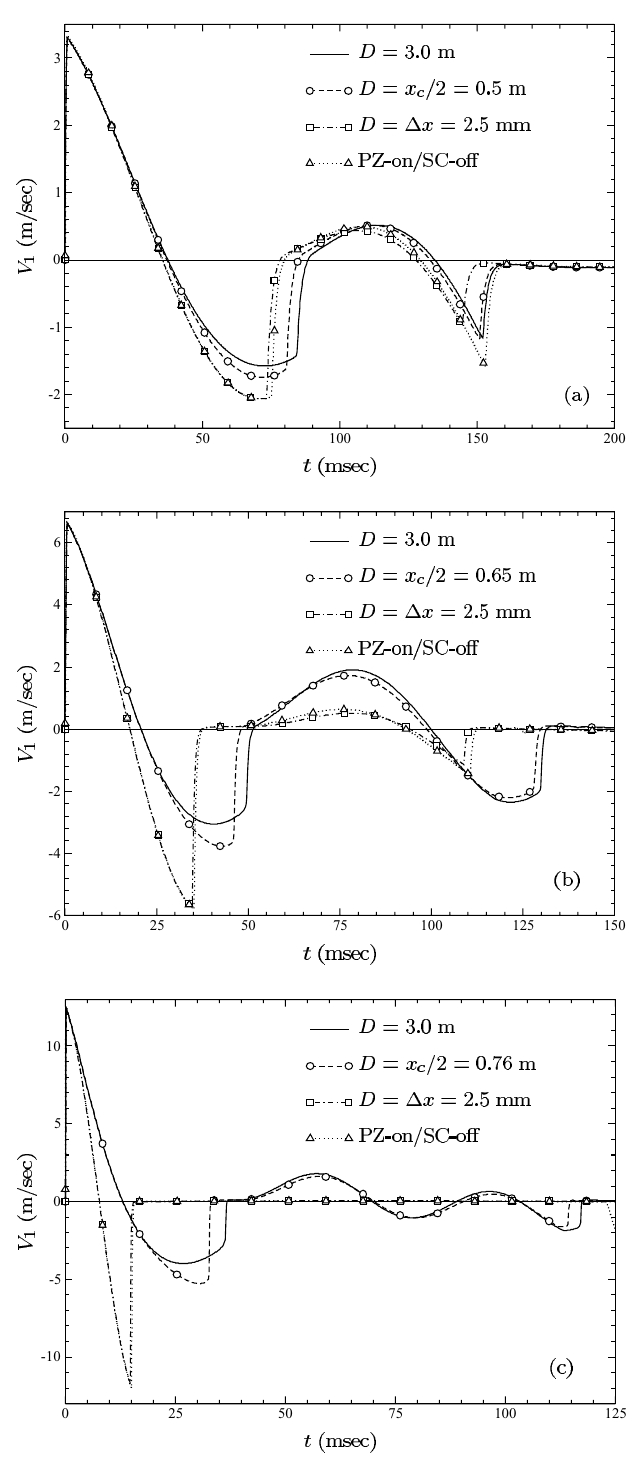
Fig. 11. V 1 -response histories for (a) M 2 /M 1 = 1 , (b) M 2 /M 1 = 5 , and (c) M 2 /M 1 = 25 , produced by truncated CAFE meshes and the PZ-on/SC-off